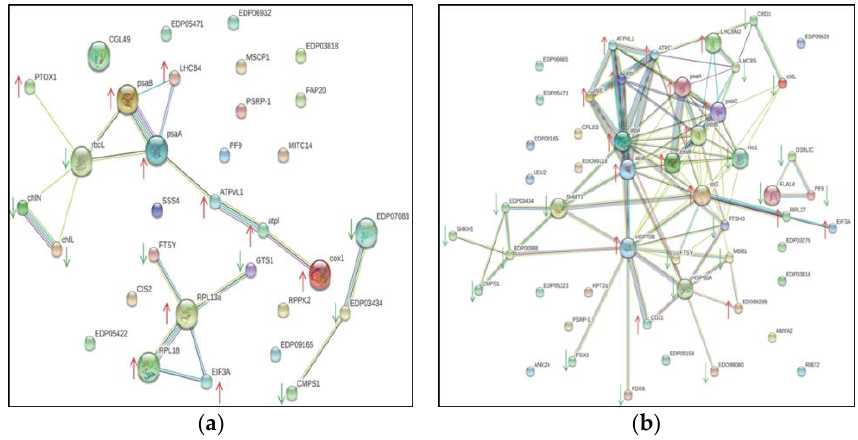
Figure 4. Search tool for the retrieval of interacting genes (STRING)-based protein – protein interaction (PPI) analysis of the DAPs in Dunaliella salina exposed to salt stress at each time point. ( a ) 3 h and ( b ) 24 h. The DAPs from D. salina were used for constructing PPI network using STRING software. The circles represent proteins while the straight lines represent the interactions between different proteins: gene fusion (red), neighborhood (green), co-occurrence across genomes (blue), protein homology (light green), co-mentioned in PubMed abstracts (yellow), experimentally determined interactions (purple), and interactions determined from curated databases (light blue). The small nodes represent proteins of unknown 3D structure, and large nodes are proteins of known or predicted 3D structure. Red arrows indicate the upregulated DAPs and green arrows indicate the downregulated DAPs.